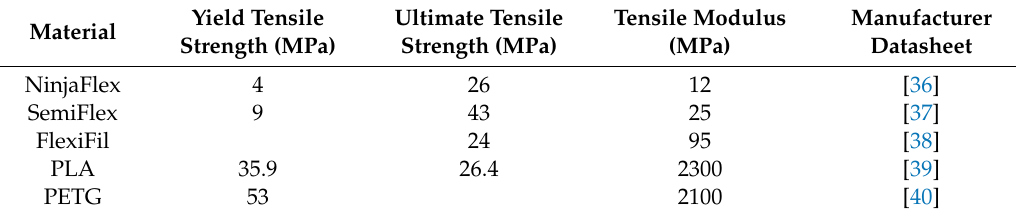
Table 1. Reported tensile values for raw filaments.